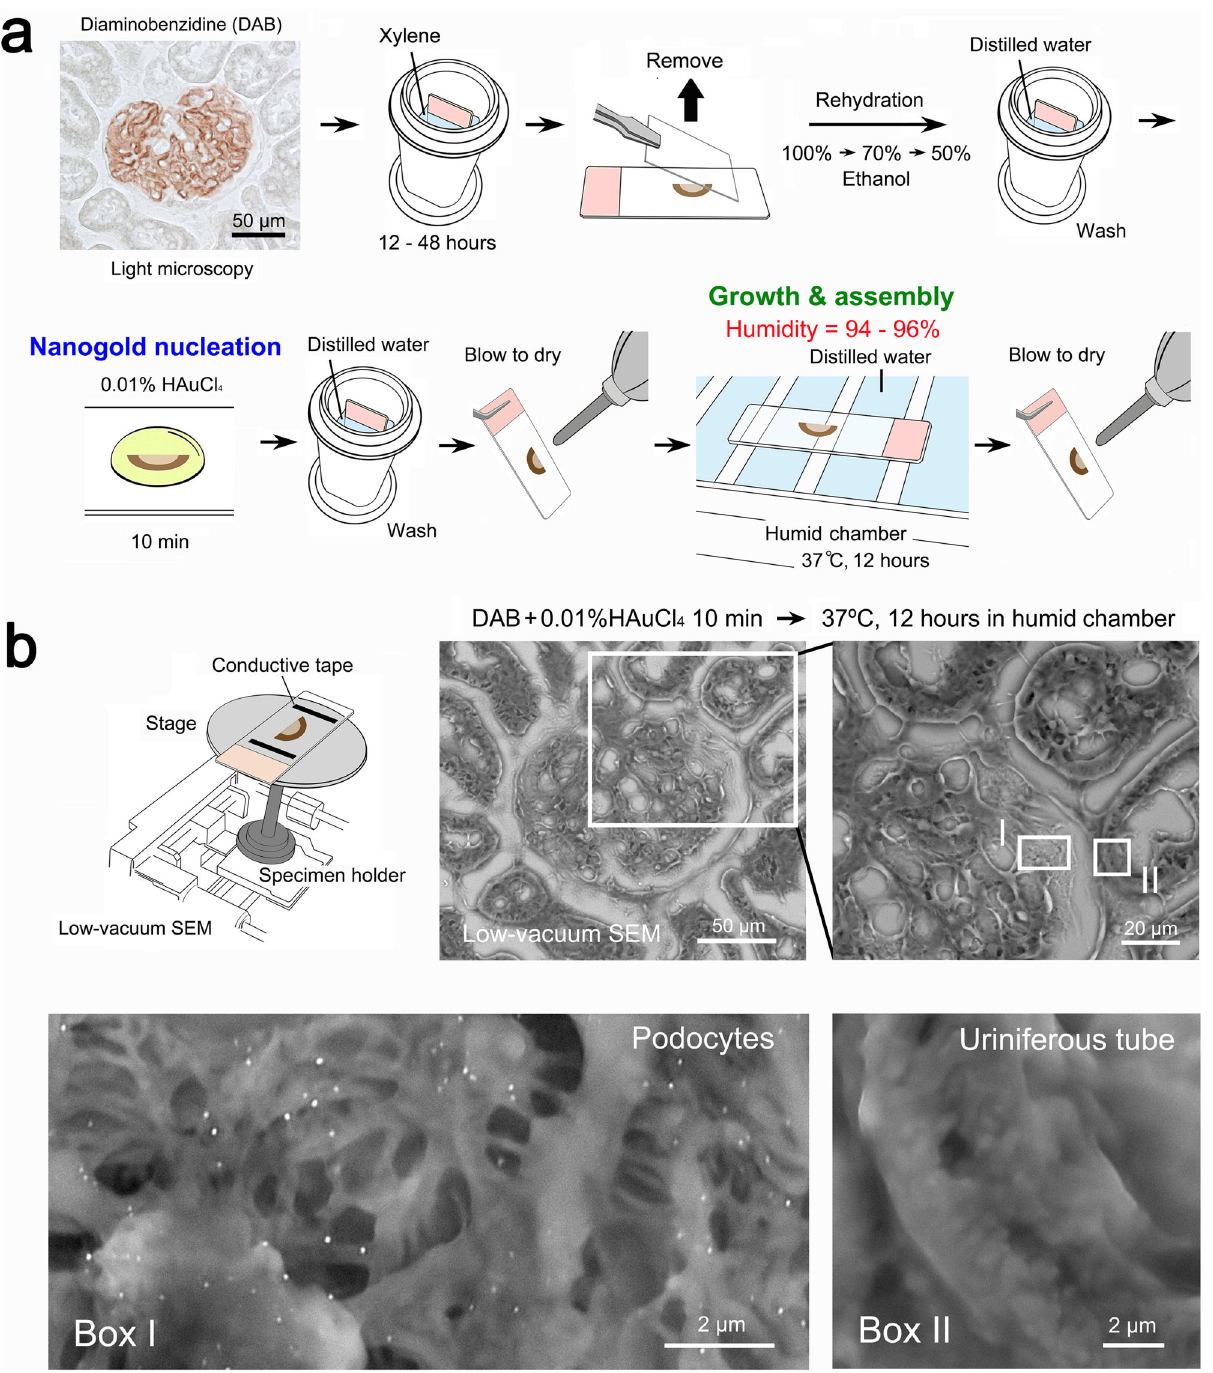
Fig. 1 Practical fl ow diagram of in situ nanogold labeling and representative electron micrographs. a First, the DAB deposition sites for the target molecules were surveyed under a light microscope. Then, the preselected microscope slides were incubated in xylene for 12 – 48 h to remove the coverslips and then rehydrated through an ethanol series. After the sections were washed in distilled water, they were treated with 0.01% HAuCl 4 for 10 min and then incubated in a humid chamber (with distilled water [DW] on the fl oor) at 37 °C for 12 h. b One microscope slide was placed on the wide stage of the specimen holder for low-vacuum SEM. The electron micrographs showed speci fi c labeling on the processes of podocytes in the kidney glomerulus (in Box I), demonstrated by correlative light and electron microscopy (compare to the light micrograph in a ). The cuboidal epithelium of the uriniferous tube, as a negative control, shows no particles (in Box